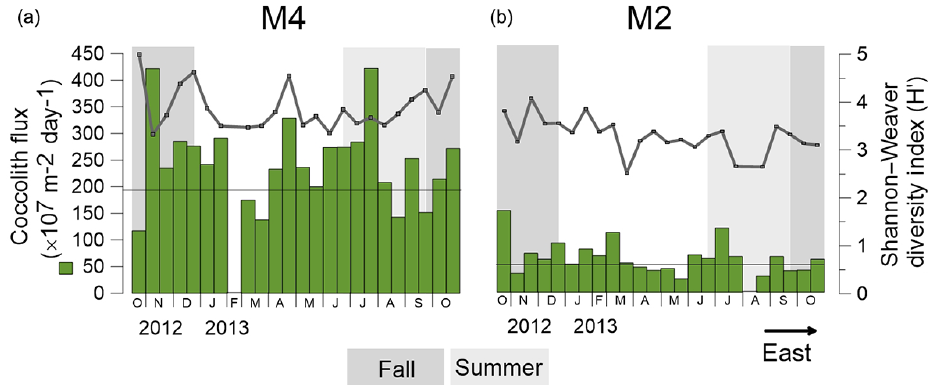
Figure 3. Temporal variation in total coccolith export fluxes (coccolithm − 2 d − 1 ; green bars), Shannon–Weaver diversity index ( H (cid:48) ; solid grey line), and annual mean coccolith flux (horizontal black line) at trap stations M4 (a) and M2 (b) .